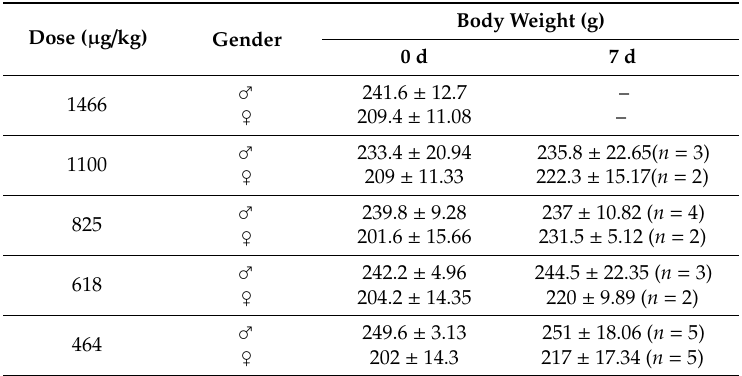
Table 3. The body weights of the SD rats after a single oral administration of sustained-release TTX pellets.